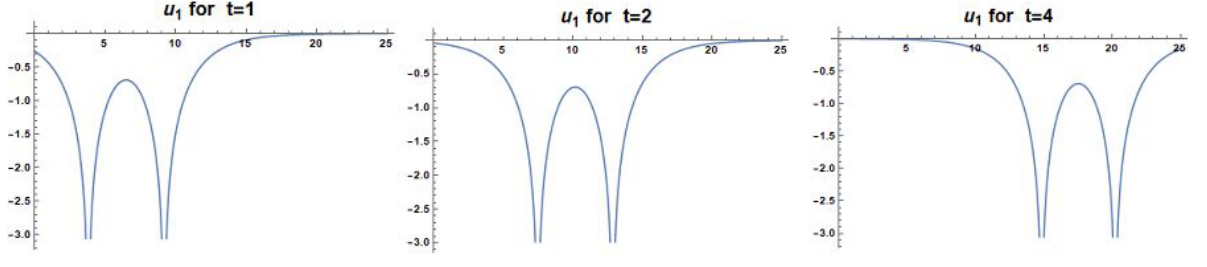
Figure 5: 3D,2D and contour graphics for A = 1, µ = 2, λ = 1, w = 1, k = 1 values of Eq. (2).